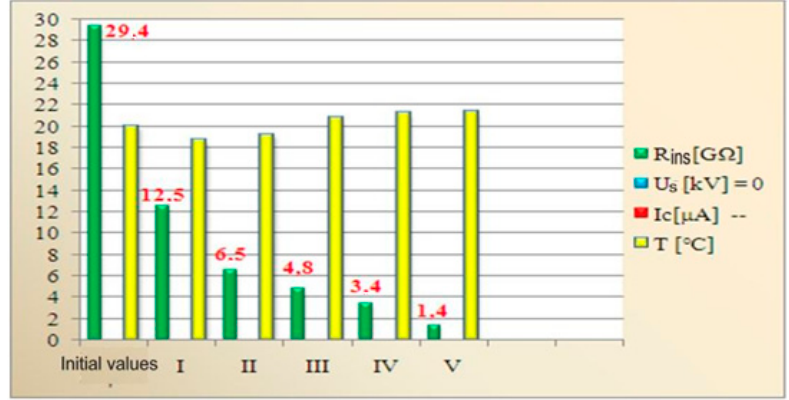
Figure 7. Graphic representation of sizes in the absence of supply voltage.